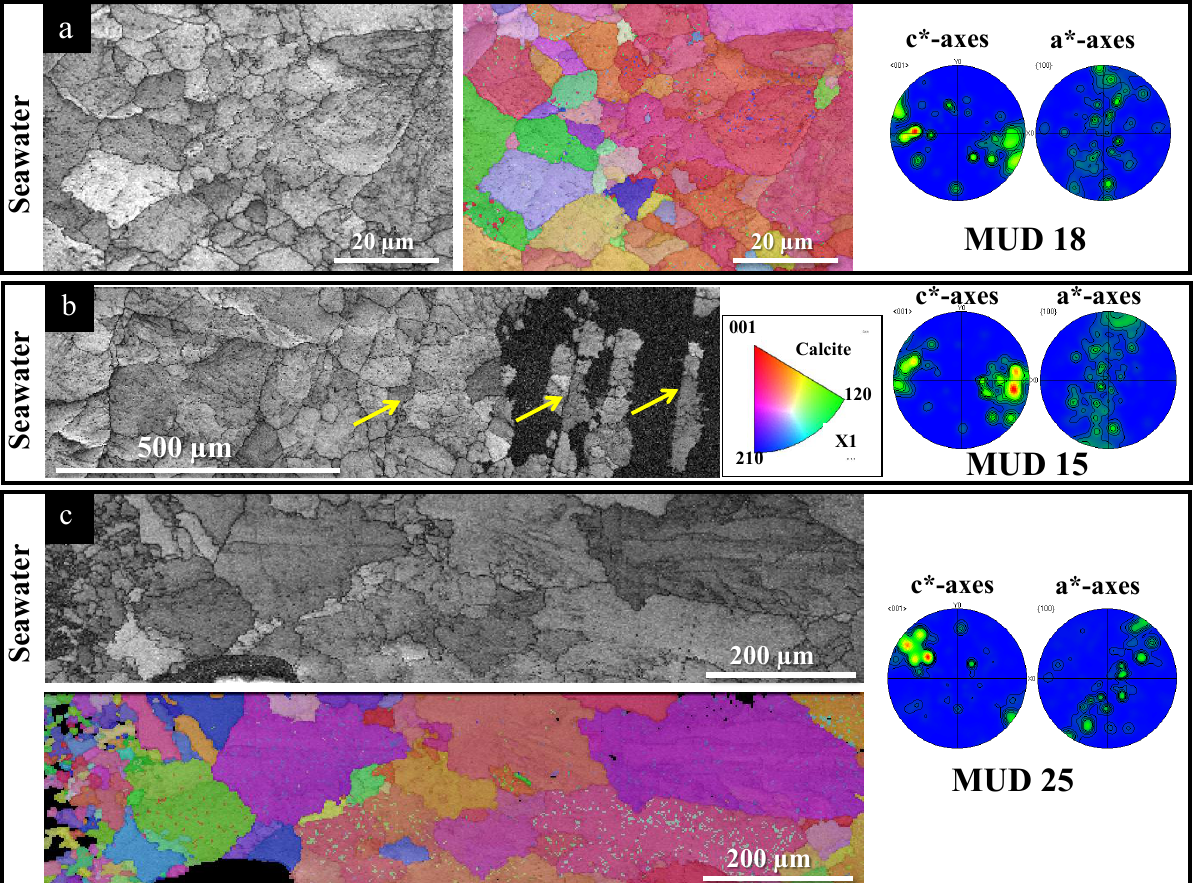
Figure 9. EBSD band contrast maps, colour-coded orientation maps, and corresponding pole figures highlight the microstructure and texture of Arctica islandica shells altered at 175 ◦ C in artificial meteoric solution. EBSD measurements shown in (a) and (b) were taken on shells that were subject to hydrothermal alteration for 7 days. Measurements shown in image C refer to shells where alteration lasted for 84 days. At 175 ◦ C, for both alteration times, aragonite was almost completely replaced by calcite and the shell microstructure is characterised by large and randomly oriented calcite crystals. The initial growth of calcite is visible at the location of former growth lines (yellow arrows in b ). For further microstructural details of the pristine shell material, see Fig.